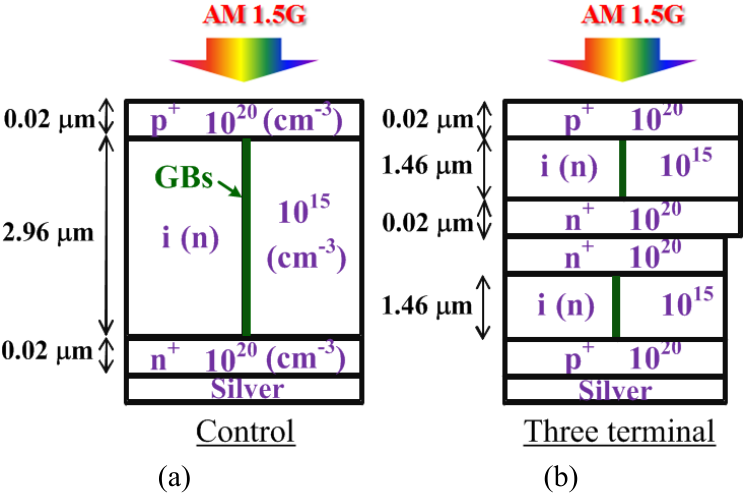
Figure 1. ( a ) The schematic structure of the typical two-terminal; and ( b ) the three-terminal μ c-Si solar cells. The unintentionally doped i-layer is assumed to be n-type as observed in the experimental